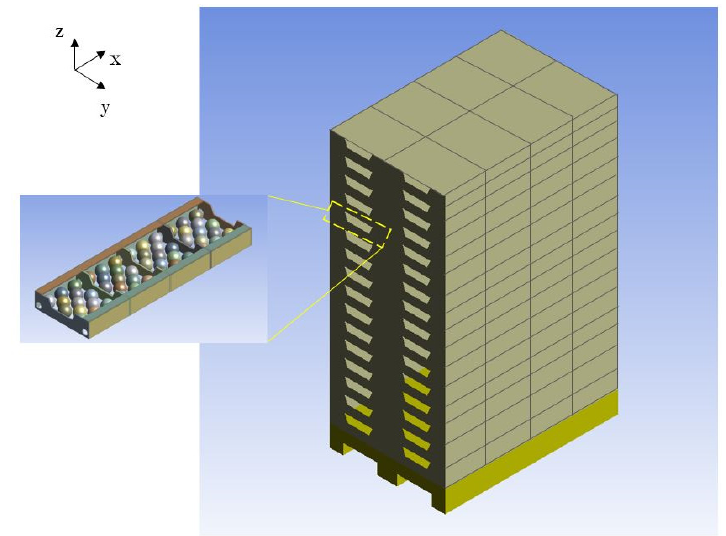
Figure 1. Current arrangement of a pallet of tomatoes (128 crates, 16